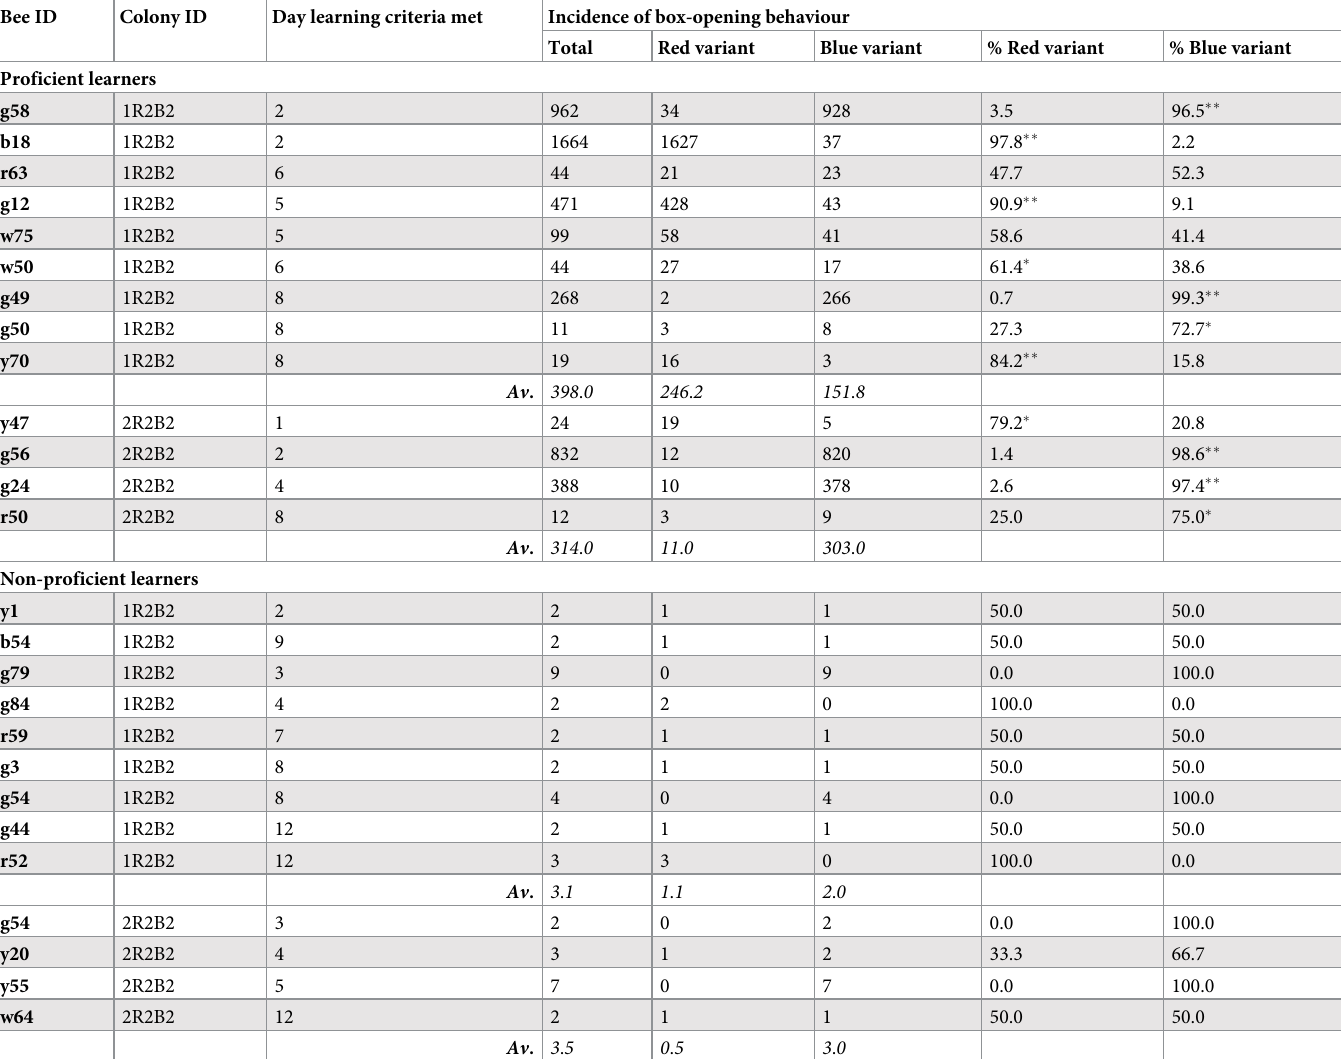
Table 3. Learner characteristics in the multiple-demonstrator diffusion